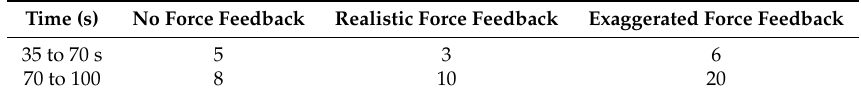
Table 4. Rise time, s ( t r ) at different time intervals.